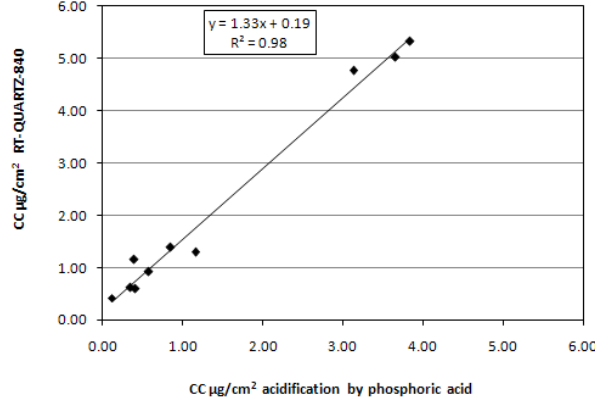
Figure 9. 2 Fig. 9. Regression between CC concentrations determined by the RT-QUARTZ-840 thermal protocol using the manual integration and by direct determination by acidification with phosphoric